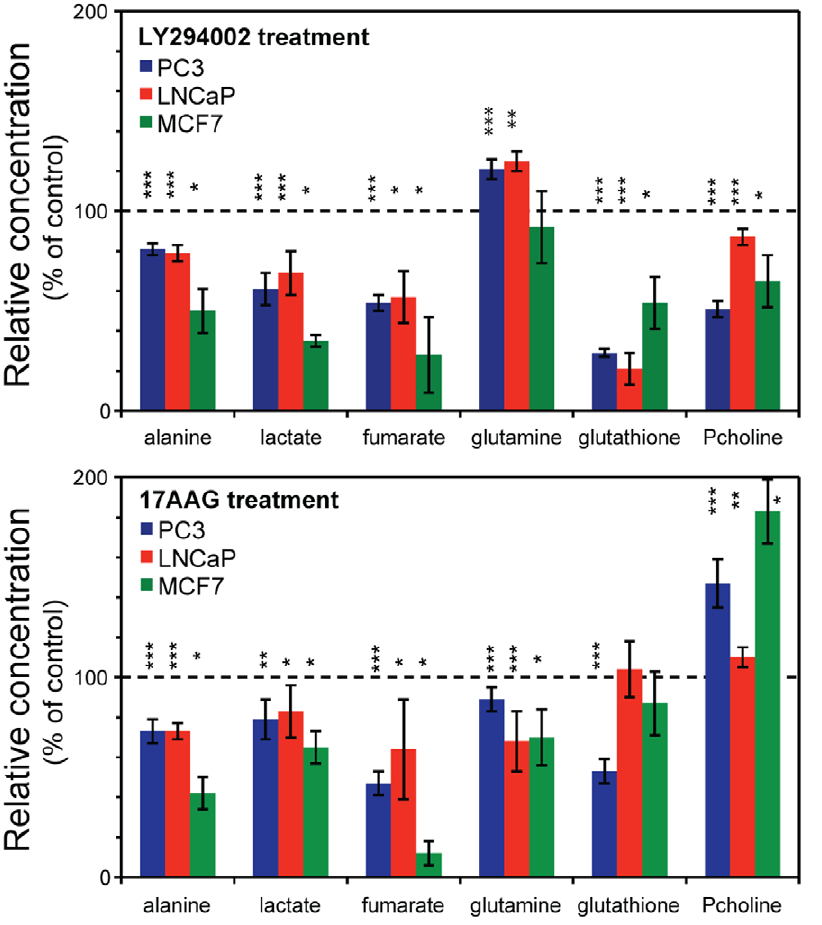
Figure 6. Common metabolic changes in prostate and breast cancer cells following drug treatment. Quantification of selected metabolites (shown as percent of control, mean 6 standard deviation) from MR spectra acquired on prostate (PC3 and LNCaP, N=8) and breast (MCF-7, N=3) cancer cell lines following 48 hours of treatment with (A) LY294002 or (B) 17AAG. *: p , 0.05; **: p , 0.005; ***: p , 0.0005. Pcholine: phosphocholine.